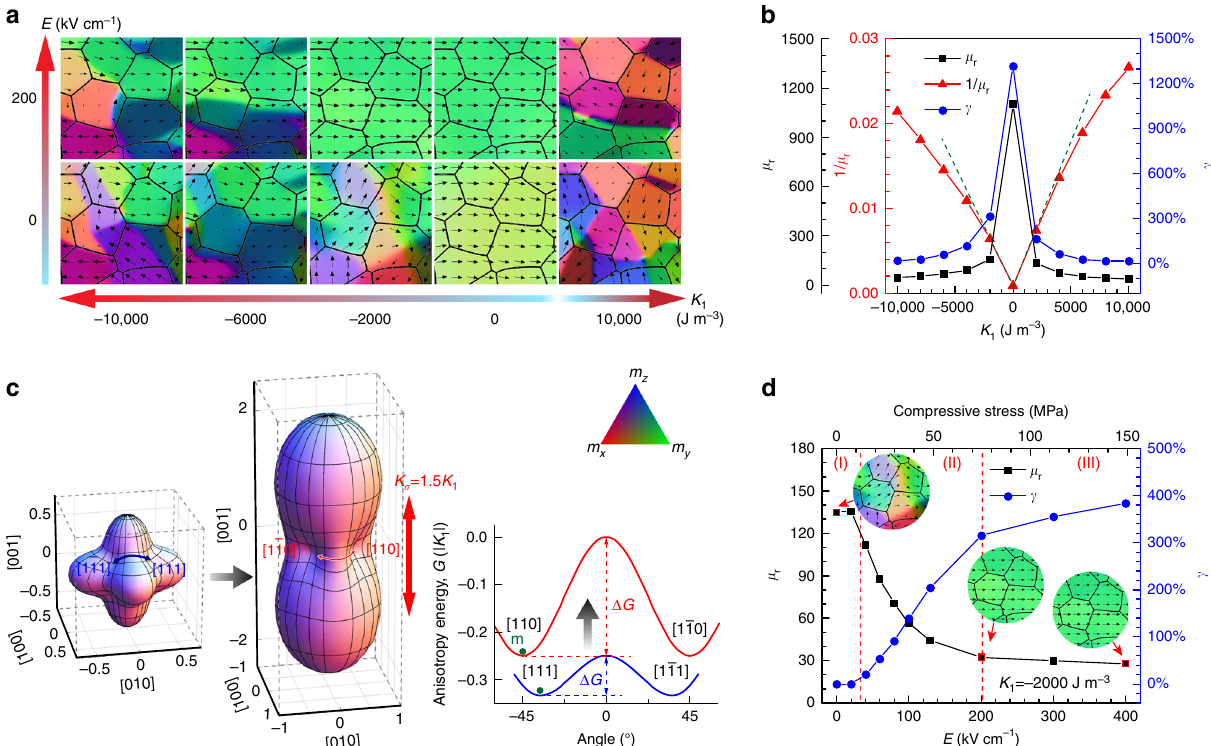
Fig. 5 Phase fi eld modeling of magnetization distribution and tuning behavior in magnetoelectric VTIs. a Magnetic domain structures of ferrite with different magnetocrystalline anisotropy K 1 under different electric fi eld E . Black arrows represent magnetization distribution. Color contours indicate the three components of magnetization. b Magnetic permeability μ r and its reciprocal 1/ μ r at E = 0 kV cm − 1 , as well as the tunability γ at E = 200 kV cm − 1 , with various MCA constants K 1 . c Free energy contour for a single grain with cubic symmetry to illustrate the stress-induced anisotropy effect on the magnetization easy axis and domain rotation pathway, where both K 1 and K σ are negative. d Magnetic permeability μ r and tunability γ as a function of electric fi eld E for VTI with MCA constant K 1 = − 2000 J m − 3 . Inset fi gures are the corresponding magnetic domain structures of ferrite under the electric